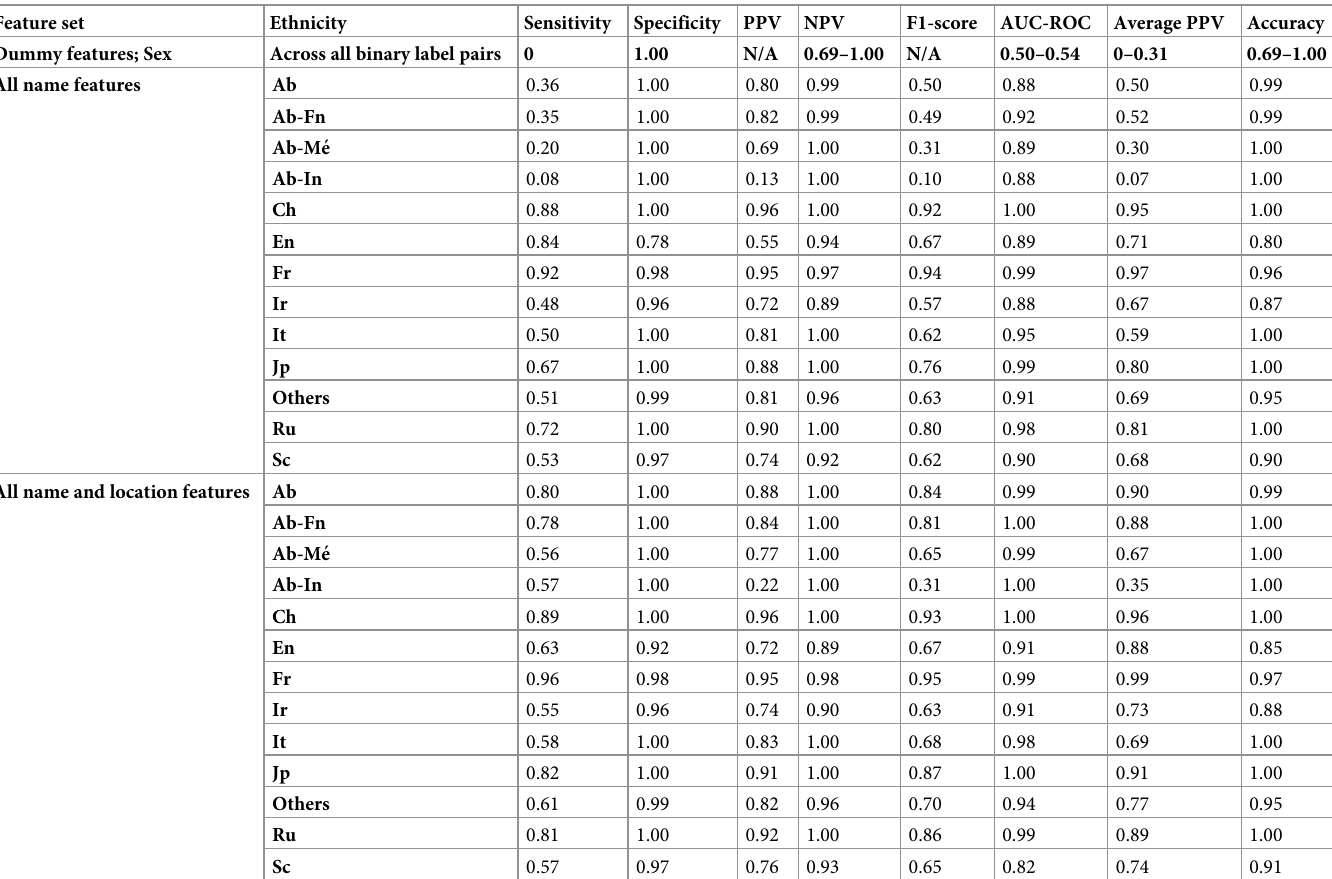
Table 6. Binary classification predictive performance in test set based on regularised logistic regression classifiers trained in training set. Feature set Dummy features; Sex